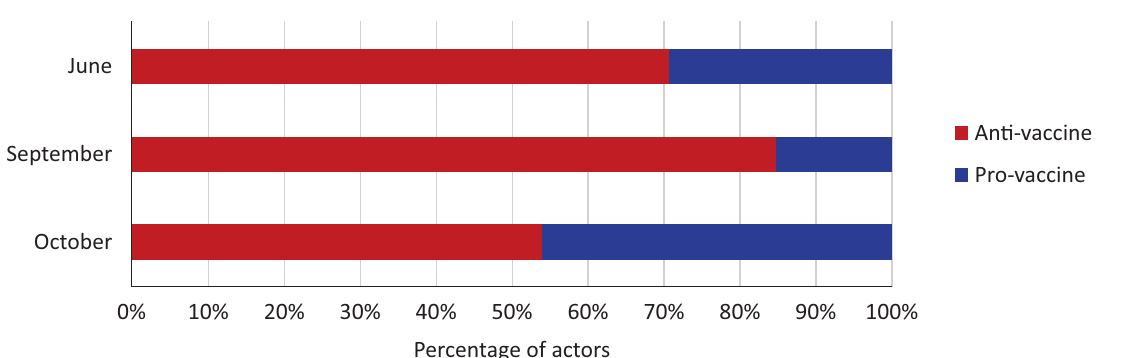
Figure 3. Percentage of anti- and pro-vaccine key actors identified in each dataset. Note: Total number of actors: 48 in June, 46 in September, 50 in October.